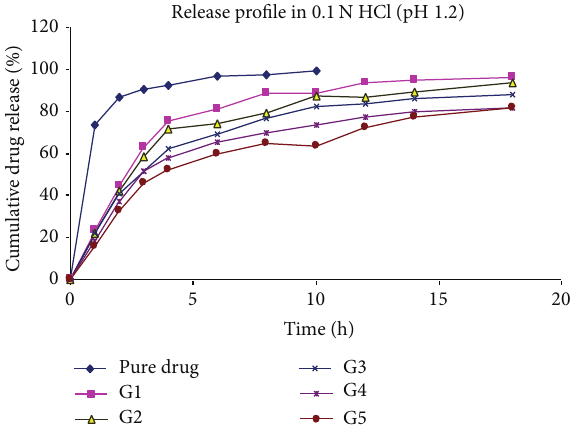
Figure 4: Effect of polymer ratio on release profile of drug in 0.1N HCl.